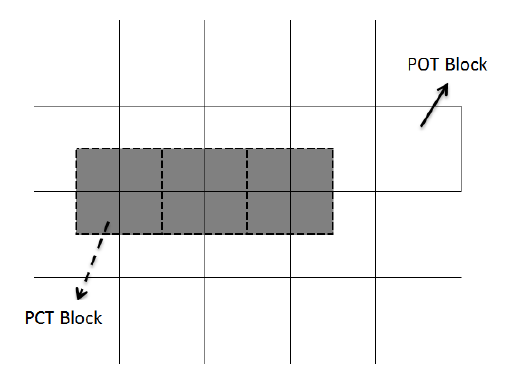
Figure 8. POT and PCT blocks